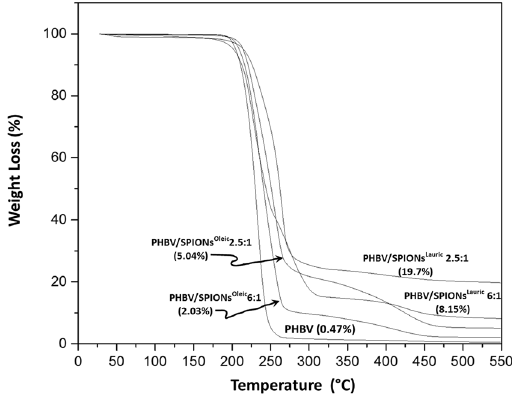
Figure 8. Thermogravimetric curves of PHBV, PHBV/SPIONs Lauric and PHBV/SPIONs Oleic showing the percentage of weight loss (%) between 27 °C and 550 °C under nitrogen flow at the heating rate of 10 °C/min.